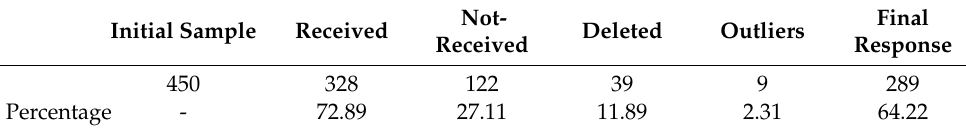
Table 1. Data cleaning stats.